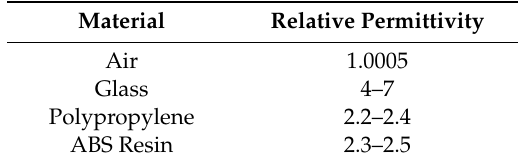
Table 1. Relative permittivity of according to material in vehicle’s exterior.